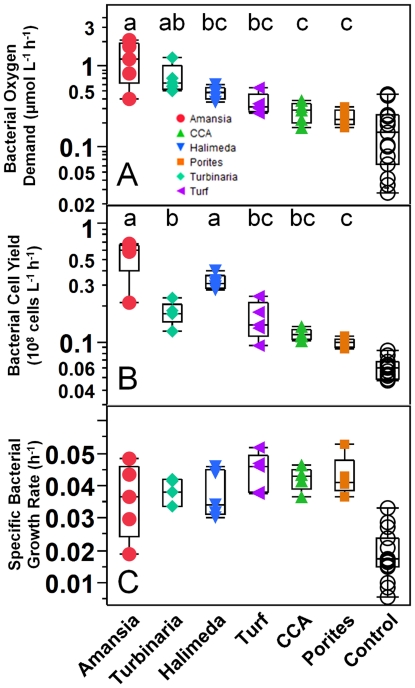
Quantiles of bacterioplankton growth and oxygen consumption in dilution culture incubations on different exudates.Panels show rates of bacterial oxygen consumption (A), bacterial cell yield (B), and bacterial specific growth rate (C). Quantile box plots (whiskers extend to 95% quantiles) are overlaid with raw replicate data points from each treatment color/symbol coded according to the legend in panel (A) and Fig. 3; treatments with the same letter are not significantly different at α = 0.05. Note that there were no significant differences among treatments in specific growth rate.